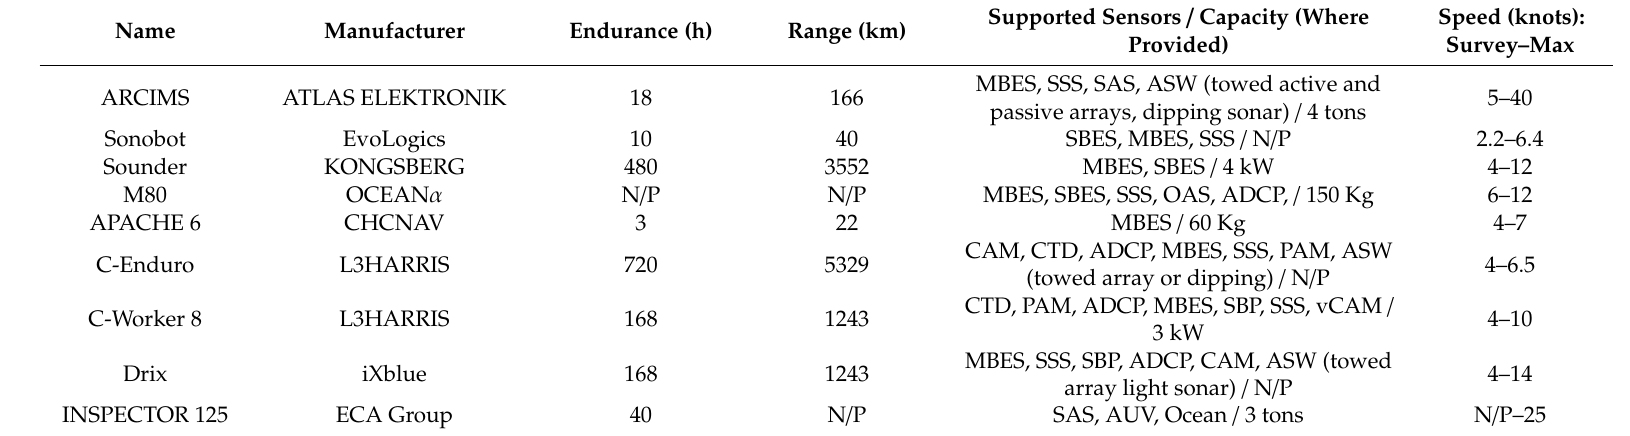
Table 2. USVs (unmanned surface vehicles) for carrying underwater sensors to survey the underwater environment of communication